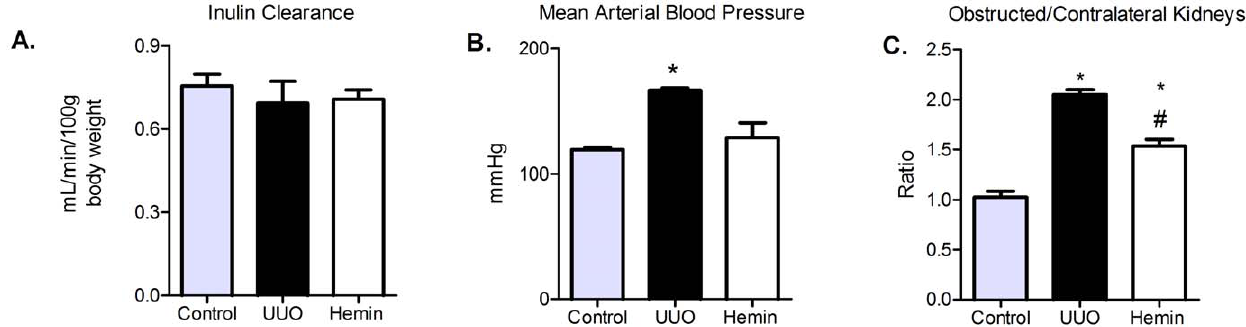
Figure 8. Role of Hemin treatment after 7 days of obstructed nephropathy on inulin clearance, mean arterial blood pressure and kidneys weight. (A) Inulin clearance was estimated by 100 g of body weight (average 6 s.e.m.). No difference between the groups were observed. (B) Mean arterial blood pressure were assessed during inulin clearance experiments (average 6 s.e.m.) * p , 0,05 vs Control and Hemin. (C) After sacrifice obstructed and contralateral kidneys were removed and weighed. After, a ratio between the kidneys were performed (average 6 s.e.m.). * p , 0,05 vs Control and # p , 0,05 vs UUO.